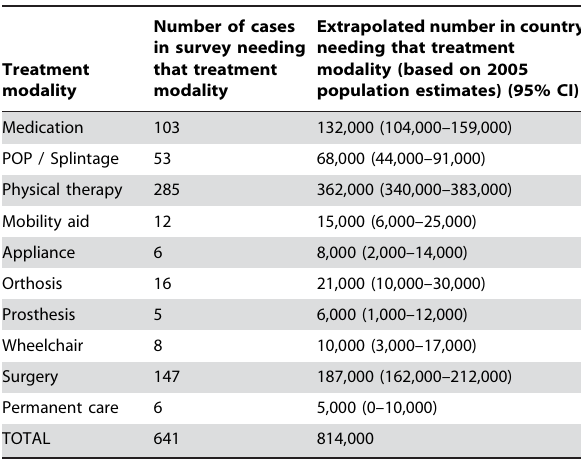
Table 5. Treatment needed among cases with MSI in survey, and extrapolated to population of